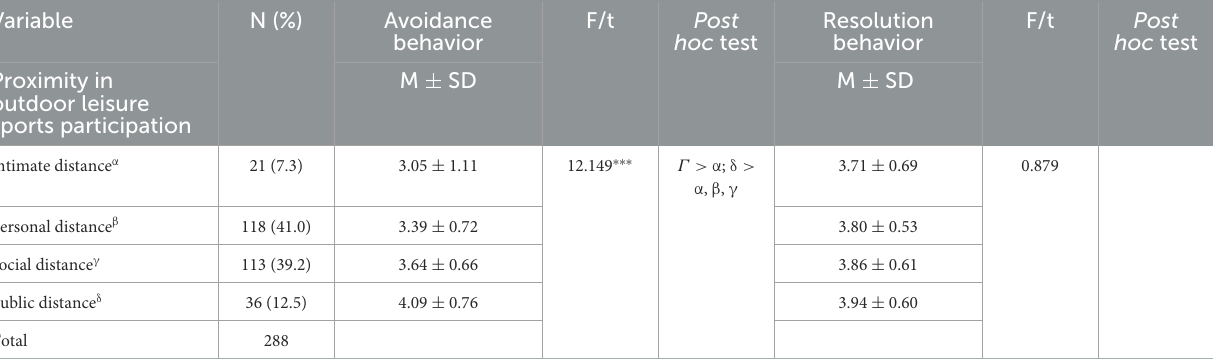
TABLE 8 Differences in coping strategies depending on spatial proximity among outdoor leisure sports ( N =